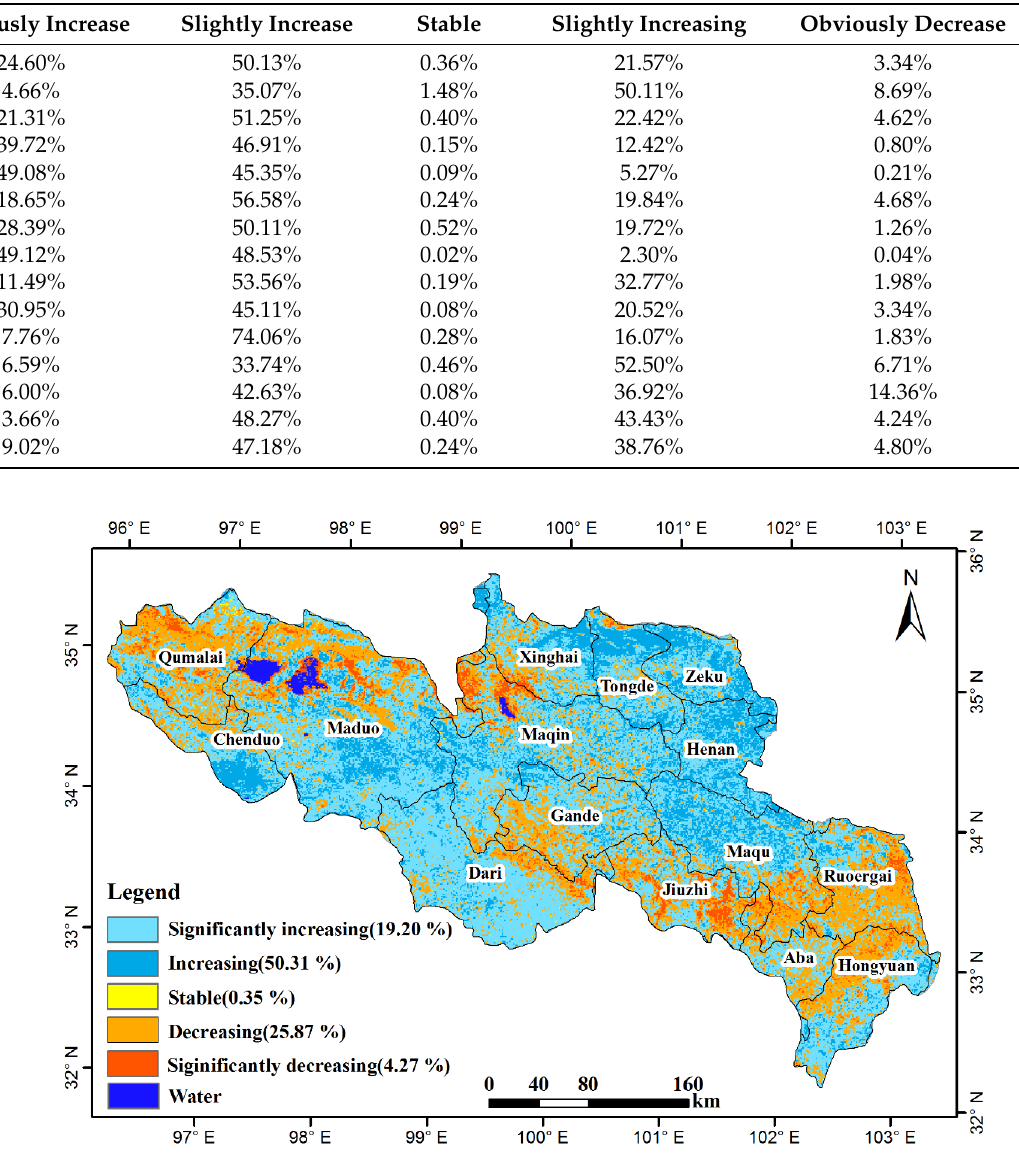
Table 4. The dynamic change trend of AGB in each county.